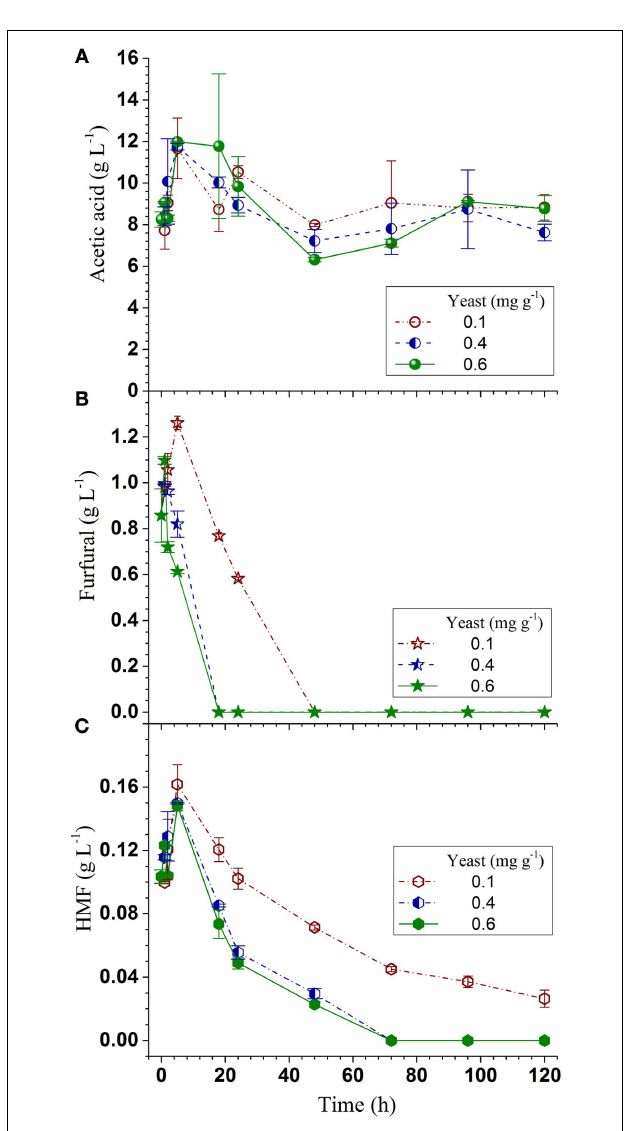
FIGURE 4 |Time-dependent inhibitor concentrations during Q-SSF of the whole slurry of SPORL pretreated NE222 at 20% total solids loading without detoxification . (A) Acetic acid; (B) Furfural; (C) HMF.